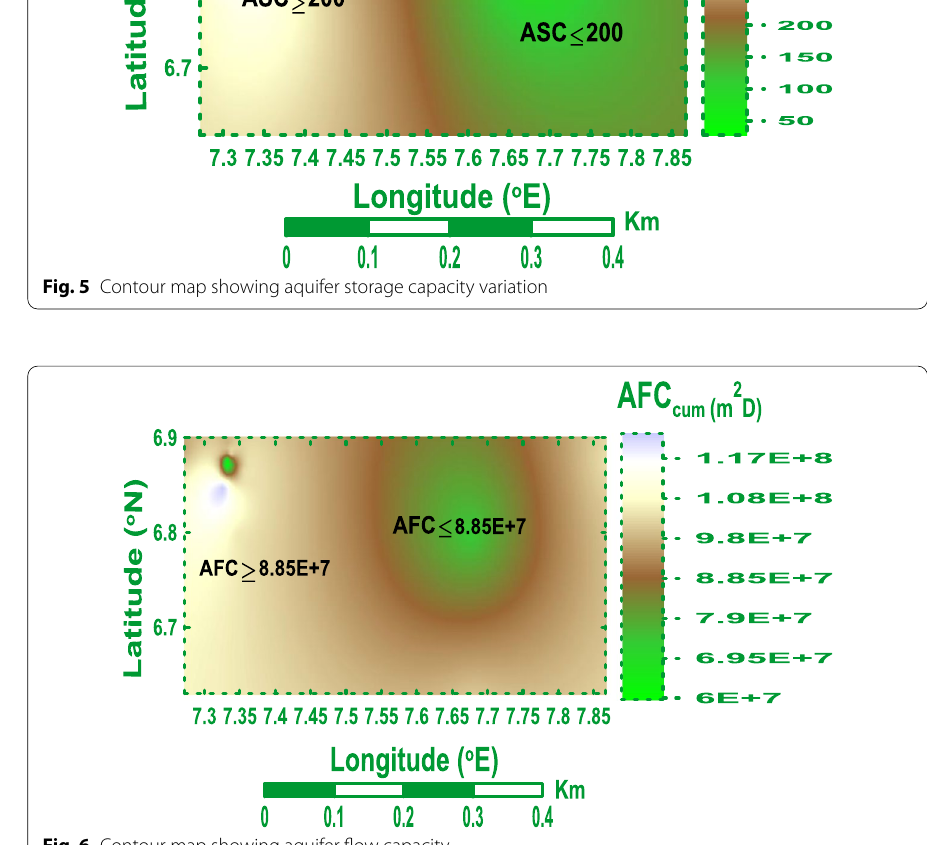
Fig. 6 Contour map showing aquifer flow